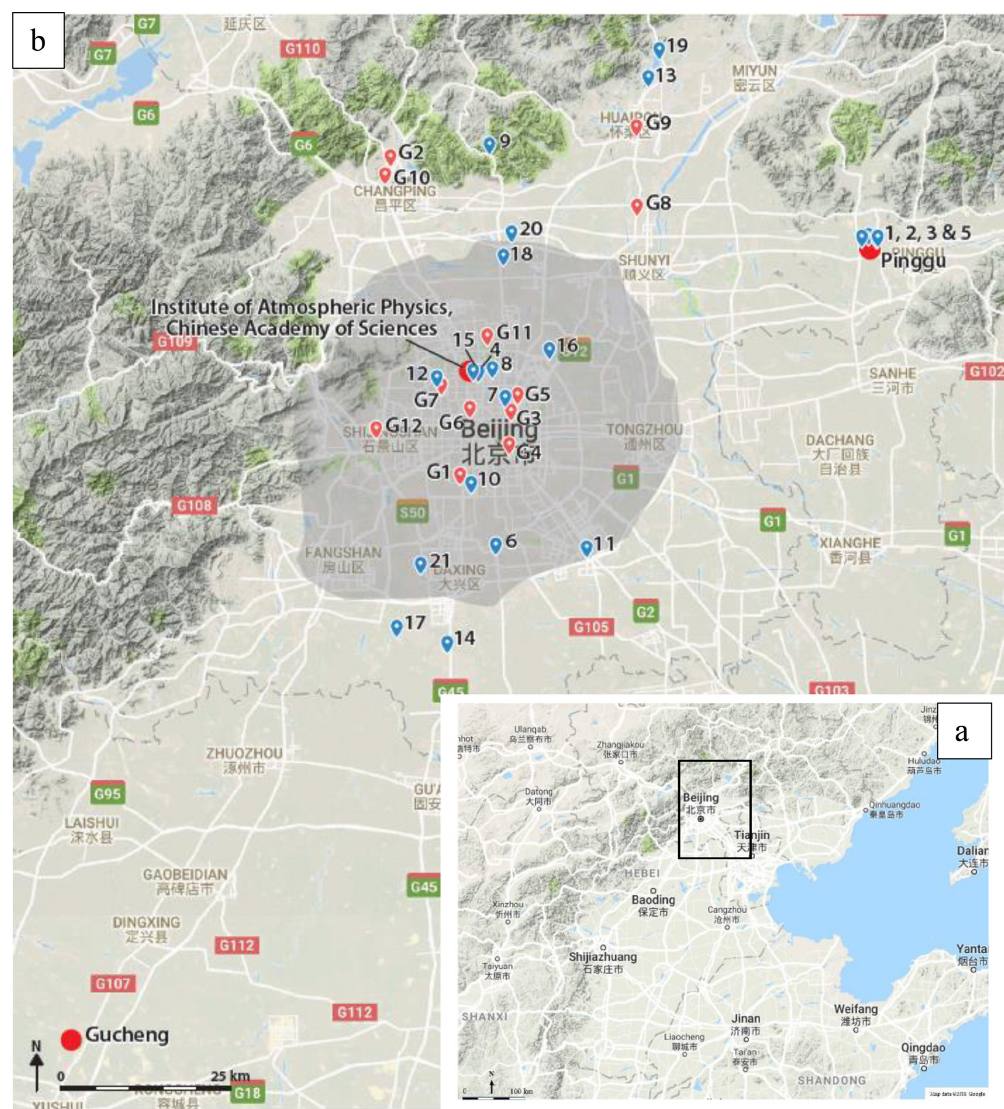
Figure 1. Study area topography (source: Google Maps) of the Beijing–Tianjin–Hebei region (a) with the rectangle showing enlarged study area; locations of measurement sites (Institute of Atmospheric Physics (IAP) – urban Beijing; Pinggu – rural Beijing; and Gucheng – upwind site in the Hebei province), SNAQ (Sensor Network for Air Quality) box sites (red symbols) and the 12 national air quality monitoring stations (G1 to G12, blue symbols) (b) . The shaded area shows the Beijing build-up area. (Source: a and b – Google Maps topographic background imagery). G1: Wanshou Xigong; G2: Dingling (Ming Tombs); G3: Dongsi; G4: Tiantan; G5: Nongzhanguan; G6: Guanyuan; G7: